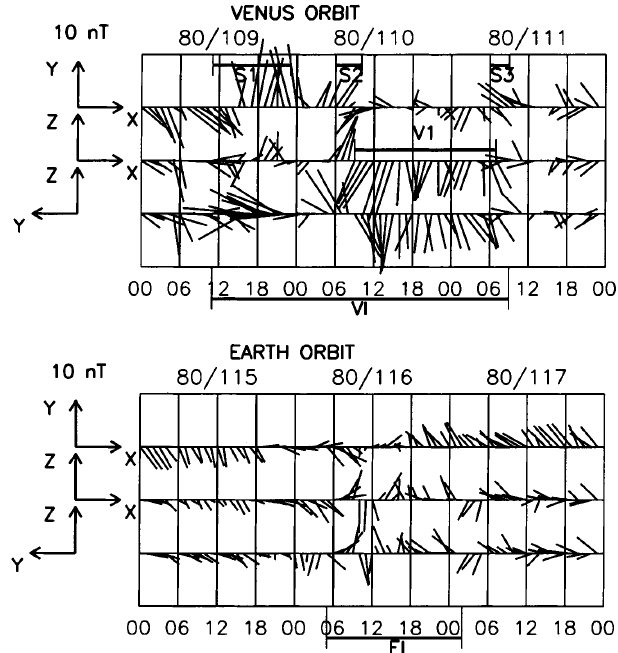
Fig. 5. IMF vector plots for sector boundary pair of no. 5 in Table 1. A multiple current sheets crossing is observed at Venus ( upper panel ), while a single current sheet is observed at Earth ( lower panel )